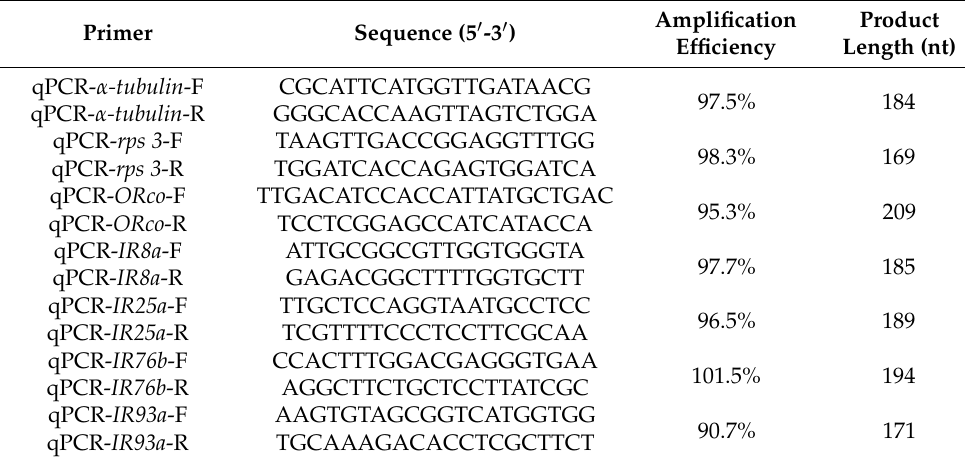
Table 1. Primer sequences of chemosensory genes used for quantitative real-time